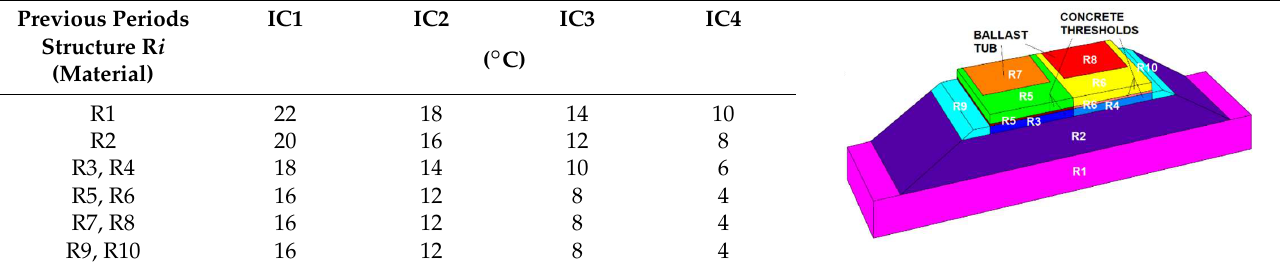
Table 4. Initial temperatures IC i as the initial condition (from previous periods: pre-periods).